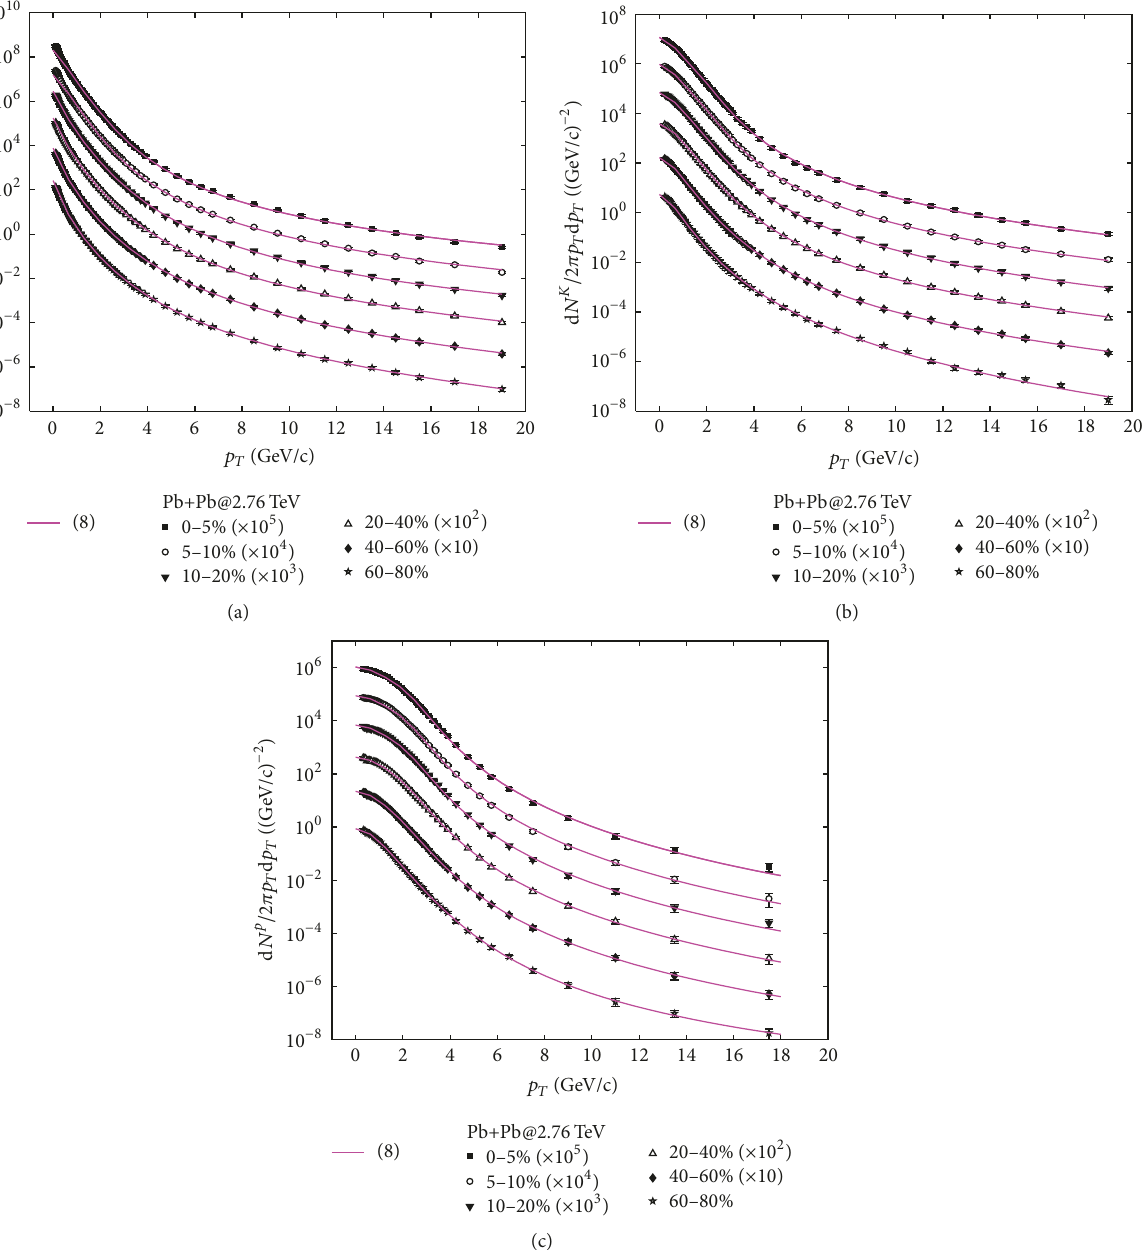
Figure 2: Fitting results using the generalized Fokker-Planck solution (8) for (a) 𝜋 + + 𝜋 − , (b) 𝐾 + + 𝐾 − , and (c) 𝑝 + 𝑝 in Pb+Pb collisions at √𝑠 = 2.76 TeV. For a better visualization both the data and the analytical curves have been scaled by a constant as indicated. Data are taken NN from ALICE